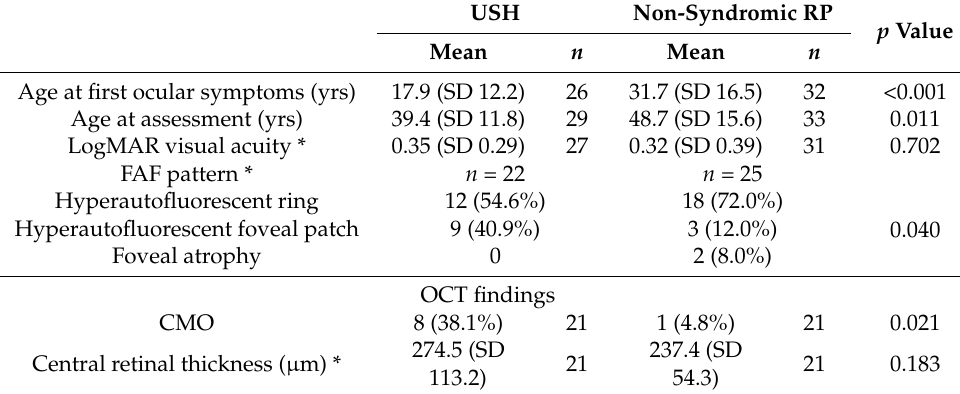
Table 1. USH vs. NS-ARRP with USH2A.